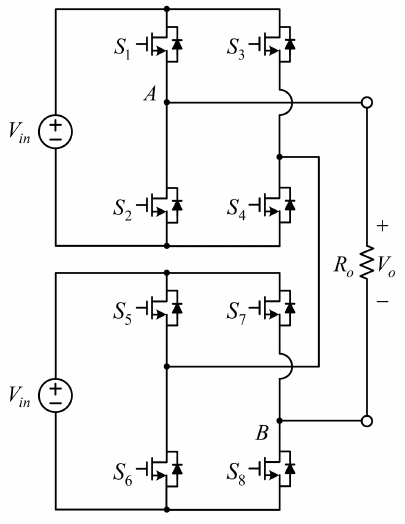
Figure 10. Circuit structure of a five-level series-connected inverter.